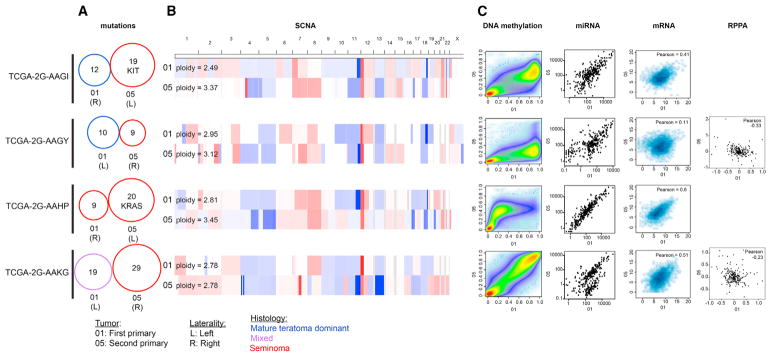
Genomic Alterations and Features in Four Patients with Asynchronous Double Primaries(A) Venn diagrams showing no overlap between somatic mutations identified in the first and second primary tumors, with number of significantly mutated genes shown. 01, first primary; 05, second primary; R, right; L, left.(B) SCNAs across the genome relative to the tumor ploidy (also shown). Red, amplification; blue, deletion.(C) For each platform, the first primary tumor is on the x axis and the second primary tumor is on the y axis. From left to right: beta values as a measure of DNA methylation across probes, with color representing the smoothed density of the probes; the reads per million (RPM) abundance of 303 miRNAs used in unsupervised clustering analysis on a log scale; log2 mRNA expression (RSEM) of 2,878 variably and highly expressed genes used for unsupervised clustering; RPPA expression values for 218 antibodies assayed. RPPA was not assessed for at least one primary tumor for patients TCGA-2G-AAGI and TCGA-2G-AAHP.